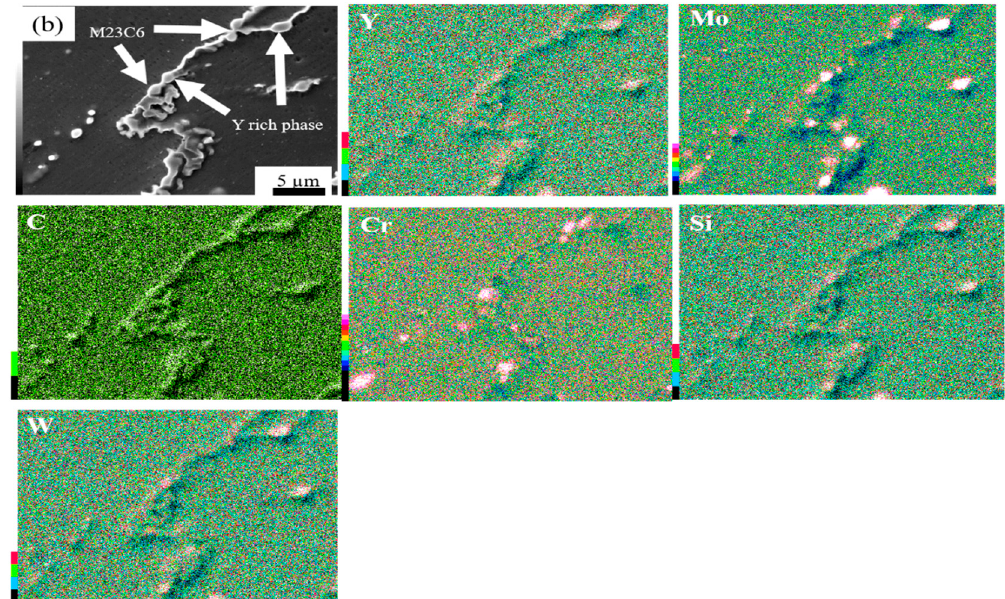
Figure 7. Grain boundary pinning effect in HX-a ( a ) as-built and ( b ) ST specimens at the grain boundary (from the intensity scale bar, the white area shows the highest region of that element).